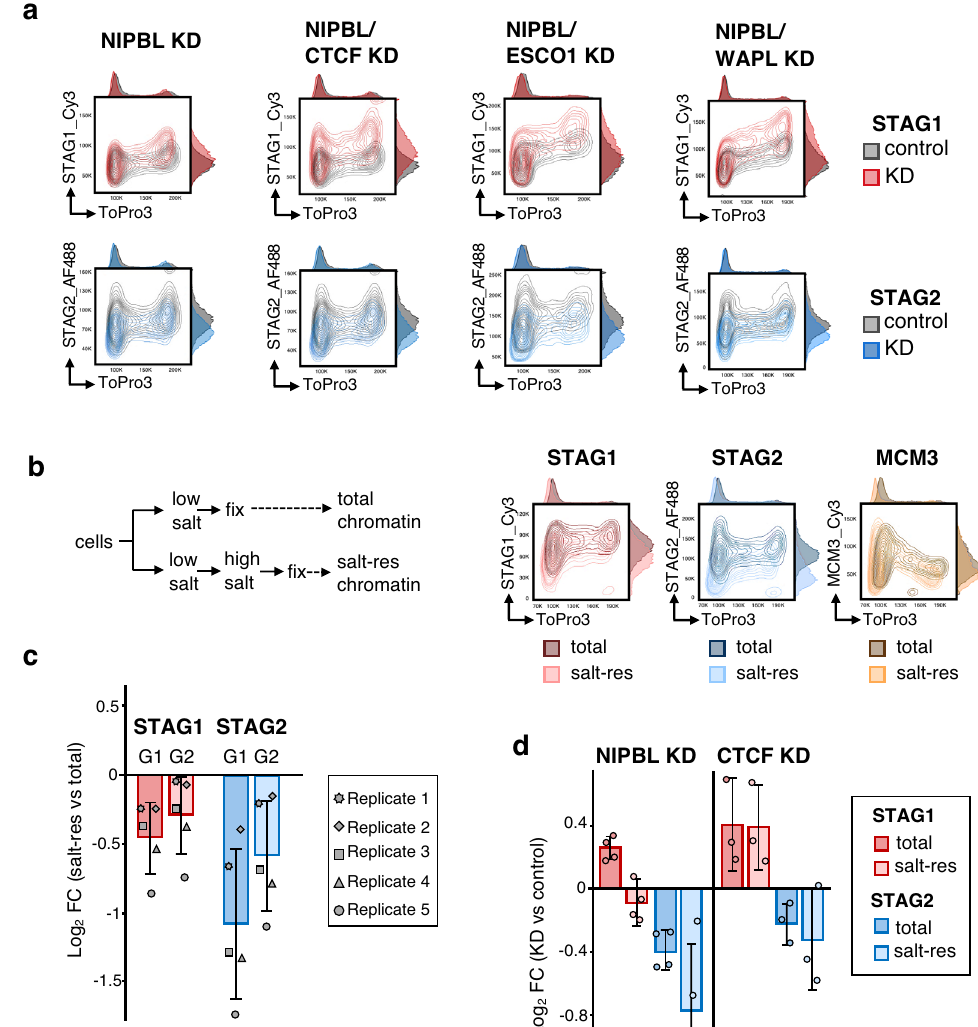
Fig.2|EffectofcohesinregulatorsontheresponseofcohesinvariantstoNIPBL KD. a Representative fl ow cytometry contour plots for chromatin-bound STAG1 and STAG2 in control (gray plots) and KD (colored plots) HeLa cells. For each double KD condition, a single KD condition was also analyzed (see Supplementary Fig. 3). The NIPBL KD plot shown corresponds to the experiment co-depleting NIPBL and CTCF. Experiments were performed three times with similar results. b Left, scheme of the experiment. Right, fl ow cytometry contour plots comparing total and salt-resistant chromatin-bound levels of STAG1, STAG2 and MCM3.